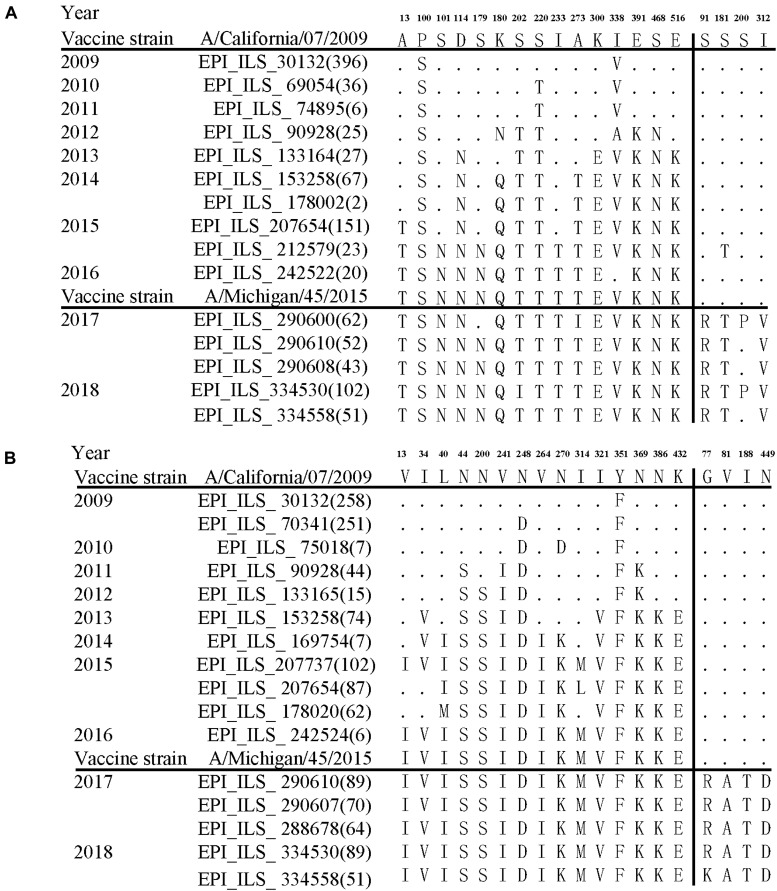
Amino acid variations of HA (A) and NA (B) glycoproteins of A/H1N1pdm virus during 2009–19 compared to the vaccine strains. The small dots indicate identical amino acids to the vaccine stain A/California/07/2009. The number of identical sequences is shown in parenthesis.